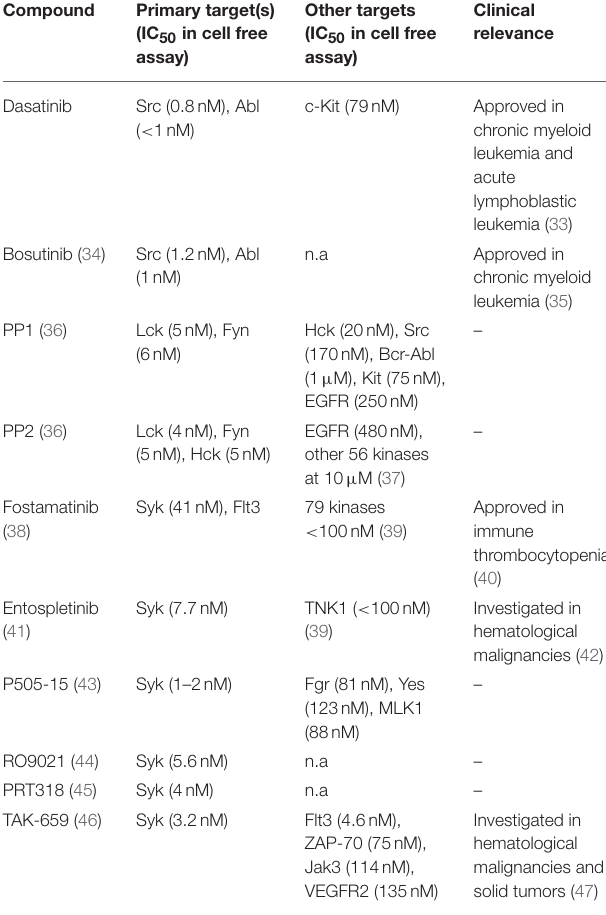
TABLE 1 | Jak inhibitors and their selectivity profile. Compound Primary target(s)